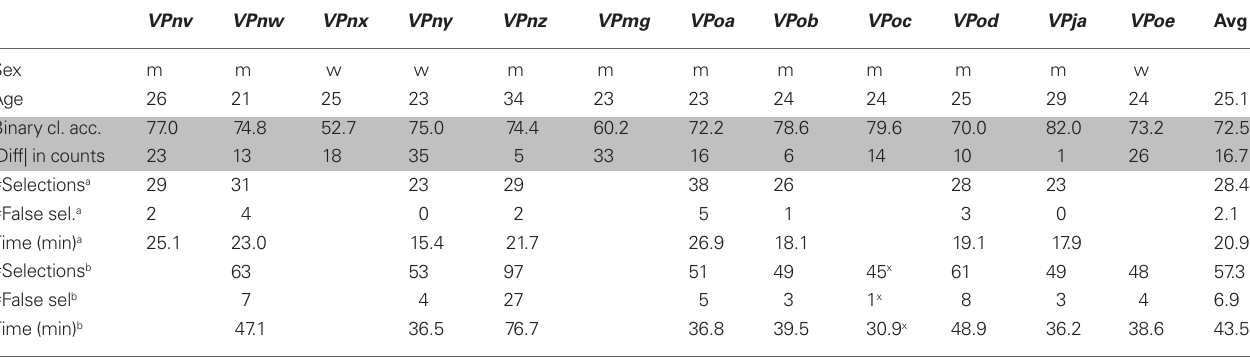
Table 1 | Subject-specific data and different measures of spelling